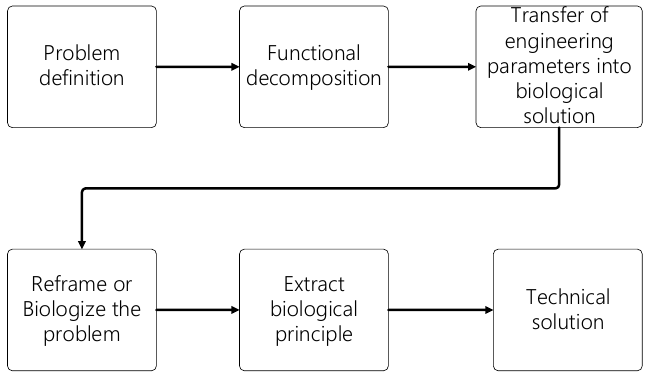
Figure 1. Biomimetic design process. Diagram created with the steps described in